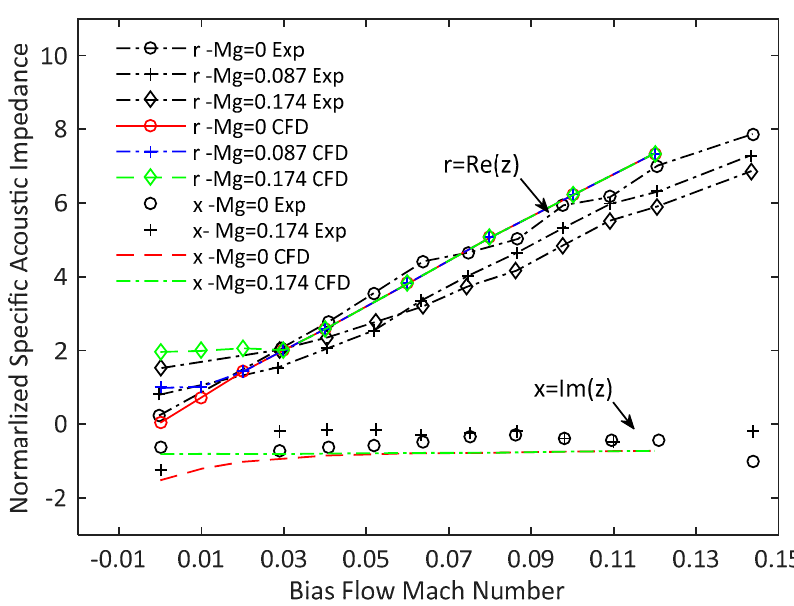
Figure 15. Numerical and experimental comparison of normalized specific acoustic impedance for liner JGB3 under various bias/grazing flow conditions [22].